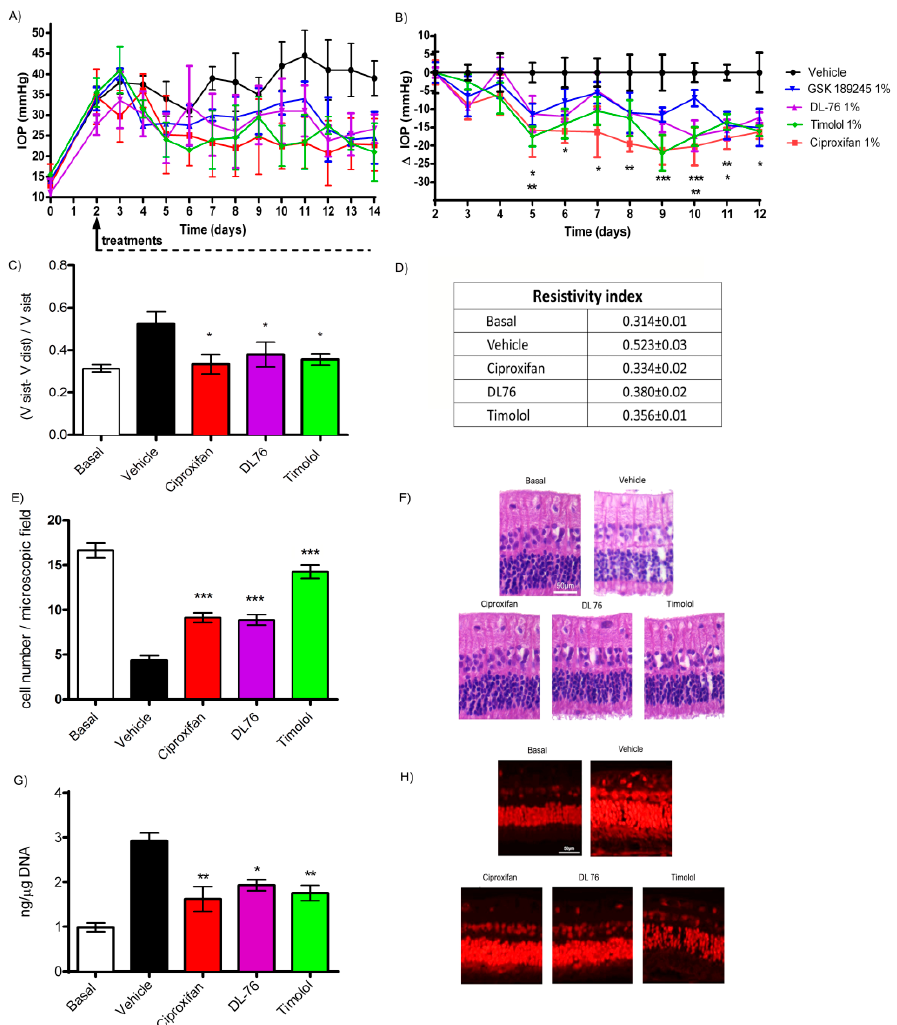
Figure 5. ( A , B ) Intraocular pressure (IOP) time course. *** p < 0.001 ciproxifan at day 9 and 10; ** p < 0.01 ciproxifan day 5, 8, 11 timolol and DL76 at day 10; * p < 0.05 ciproxifan at day 5, 6, 7, 12, DL76 and